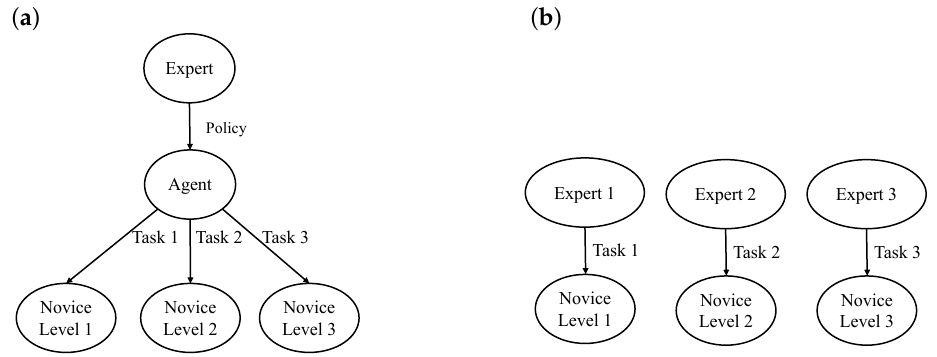
Figure 2. Comparison of training methods based on RL and one-to-one training mode. ( a ) RL-based training mode. ( b ) Traditional one-to-one training